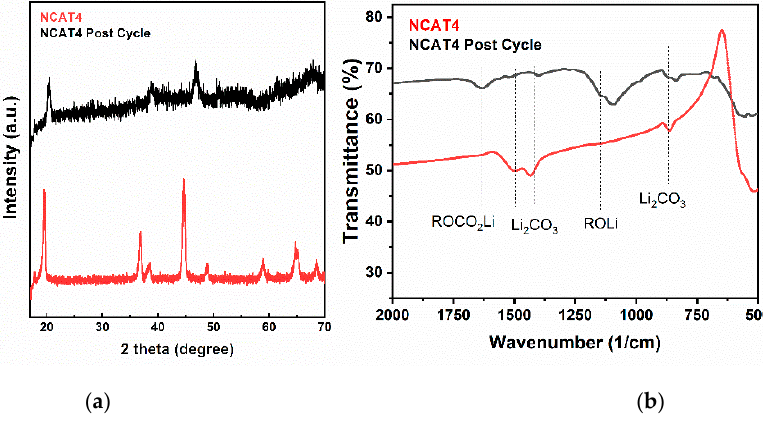
Figure 16. ( a ) XRD pattern and ( b ) FTIR spectra of NCAT4/NCAM2 before and after cycling.